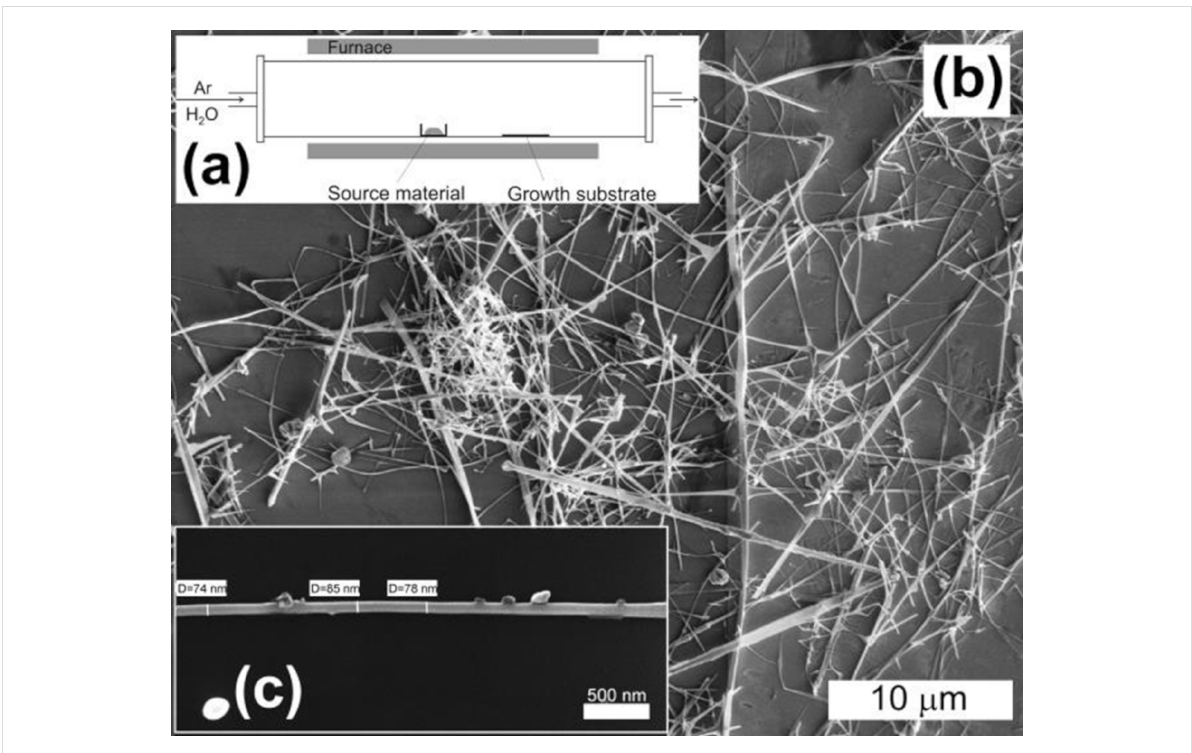
Figure 1: Scheme of nanowire synthesis (a), SEM image of SnO 2 nanowires after synthesis (b), SEM image of a single SnO 2 nanowire